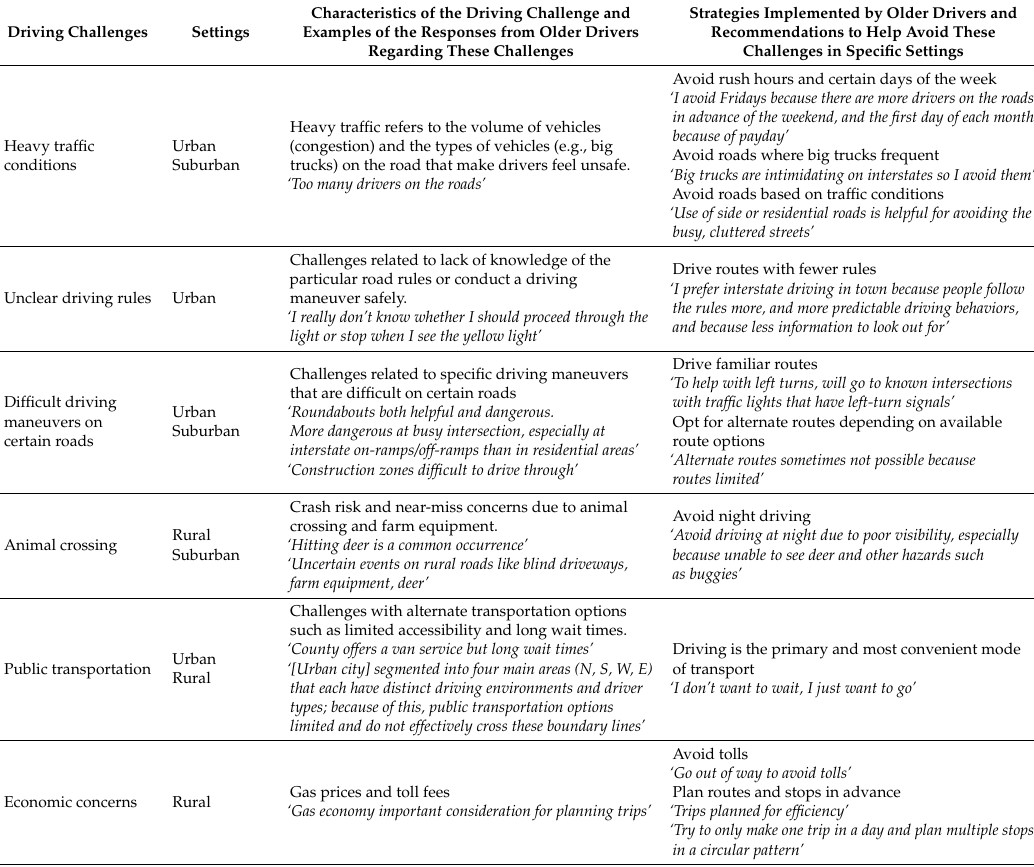
Table 3. Location-specific driving challenges of older drivers and the strategies implemented to overcome their driving